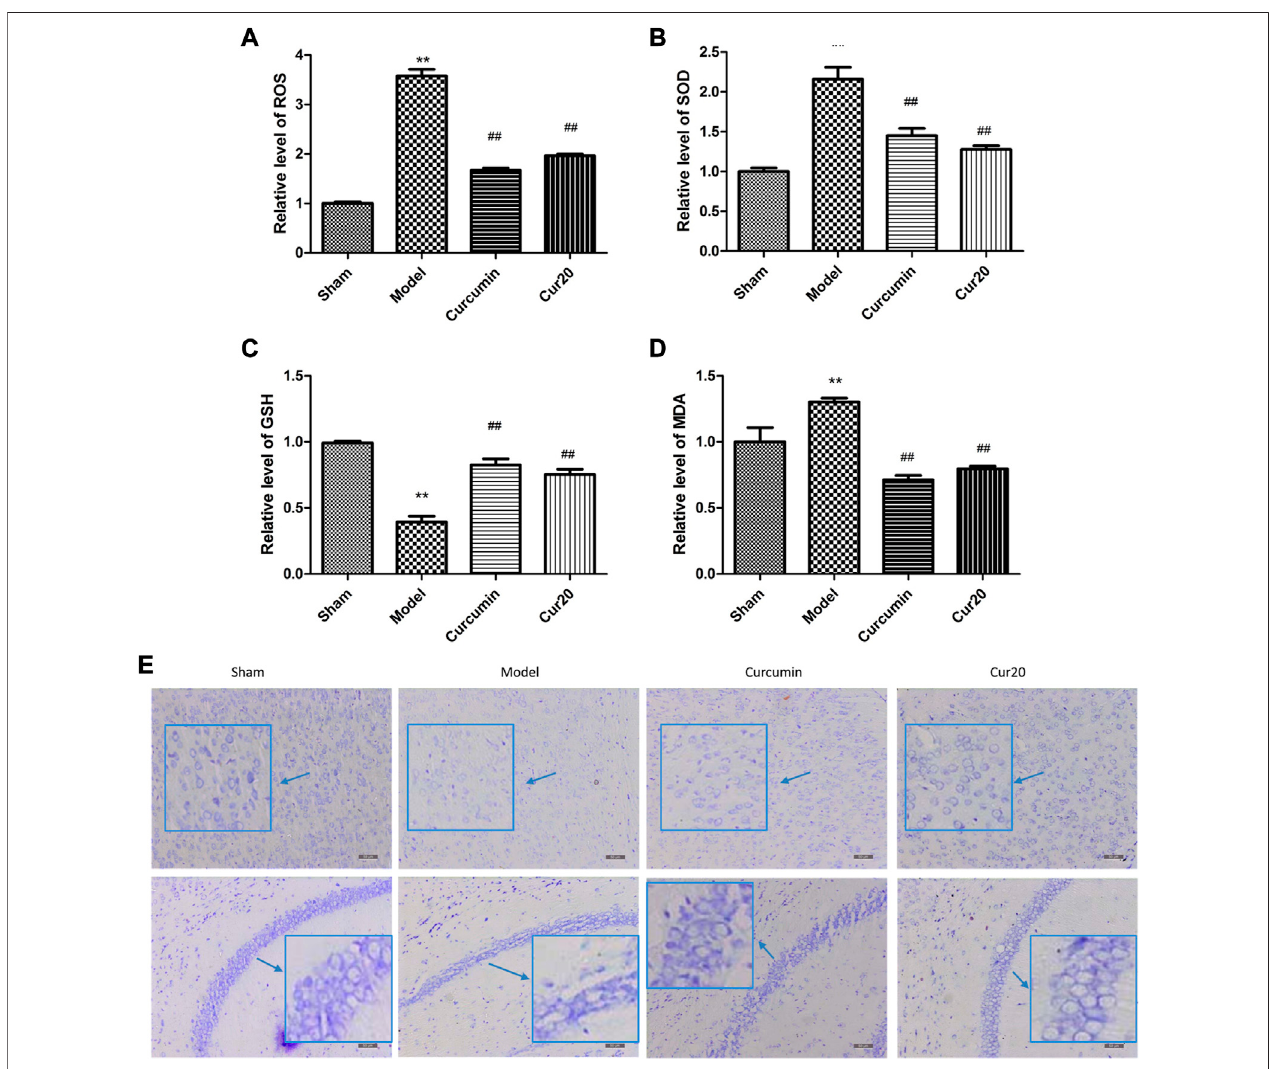
FIGURE5| Cur20 exerted antioxidant effect and preventedneuronloss incerebral cortex and hippocampus. Relative content ofROS (A) , SOD (B) ,GSH (C), and MDA (D) in brain homogenate. E , Nissl stain reveal the effect of Cur20 on the morphology improvement in cortex and hippocampus in animal models of vascular dementia (200 × ). ** p < 0.01 vs. Sham group; ## p < 0.01 vs. Model